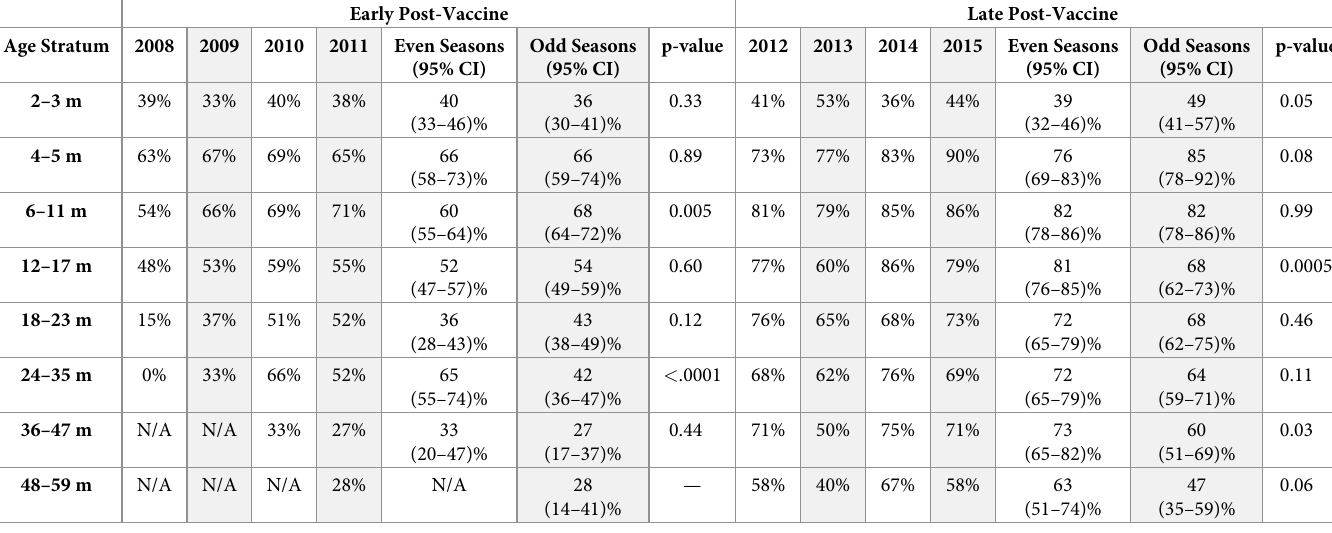
Table 4. Rotavirus vaccination coverage ( (cid:21) 1 rotavirus vaccination) stratified by age and rotavirus season (Jan-Jun) for children < 60 months admitted for acute gastroenteritis, 2008–2015. P-value comparison is for odd vs. even seasons. Early